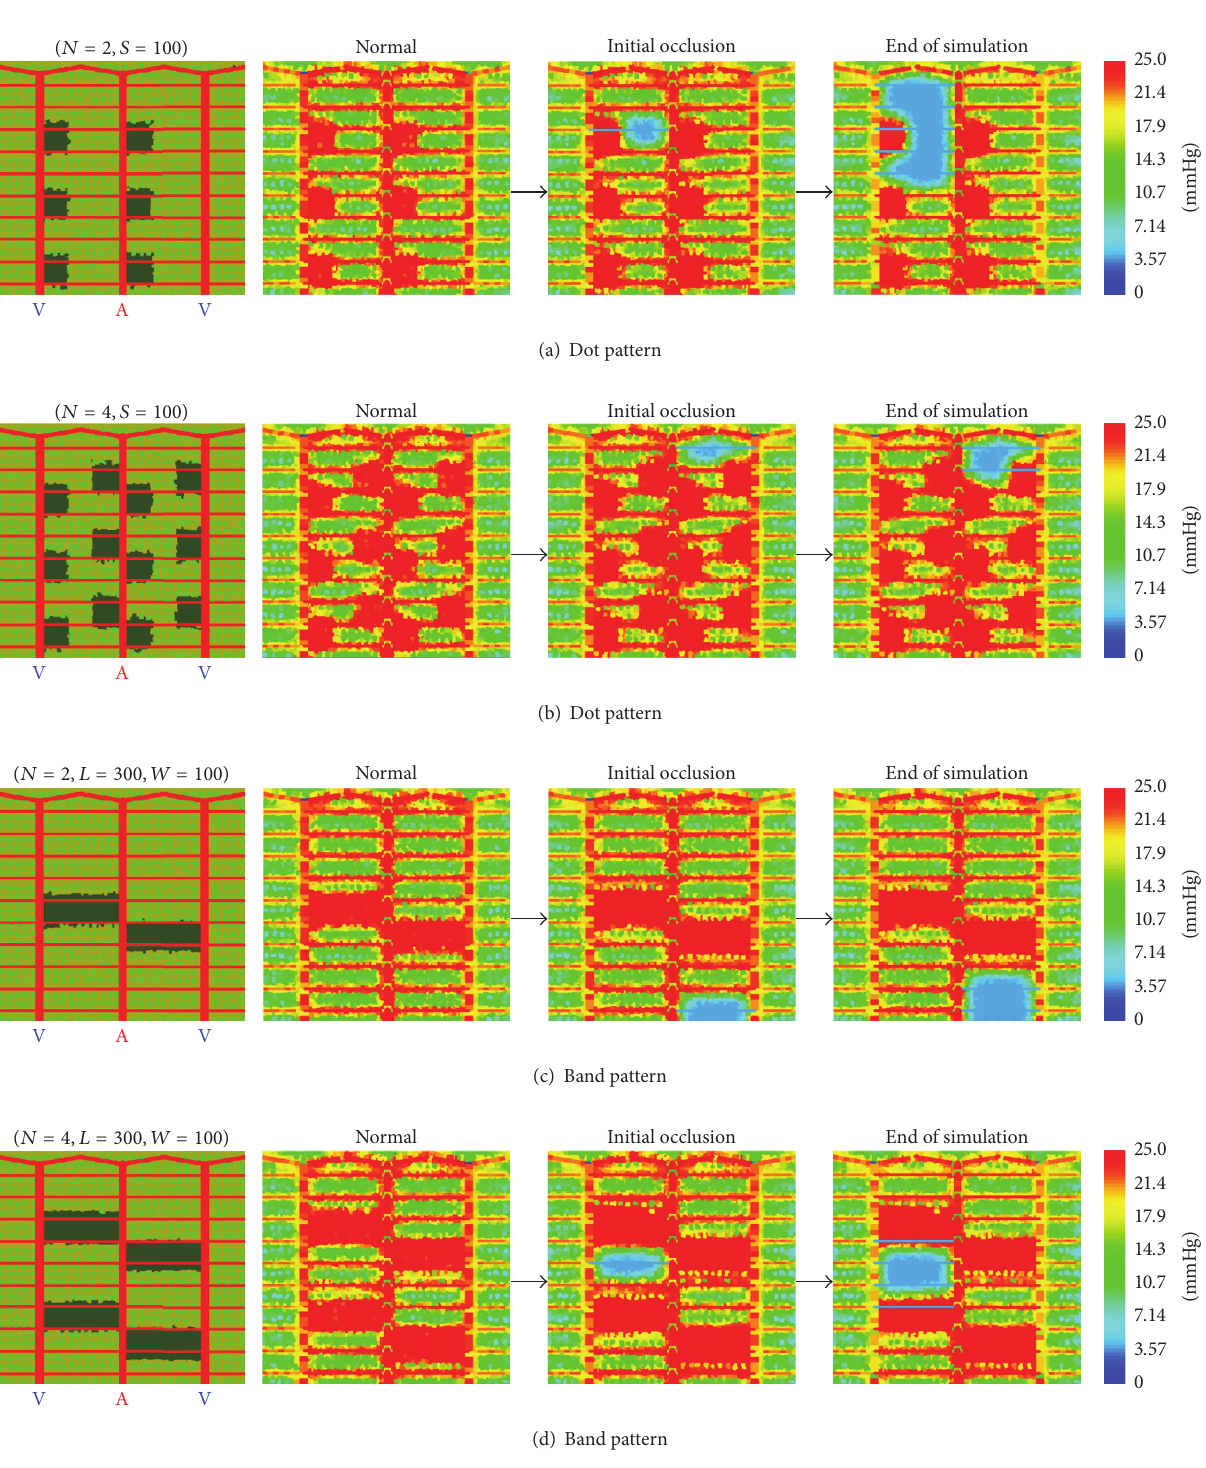
Figure 2: Dot and band burns patterns: effects of density. Effects of dot and band laser burn density on ischemia progression. Dot pattern burn (first subfigure rows (a) and (b)) with 𝑁 = 2 (a) and 𝑁 = 4 (b) and their effectiveness on prevention of ischemia progression (second to fourth subfigures in each row). Label 𝑁 = 2 indicates that the initial sum ablated area of these dot pattern burns is equivalent to that with two band pattern burns. Label 𝑆 = 100 means that the edge of the dot pattern burn is 100 microns. Band pattern burns (first subfigure rows (c) and (d)) with 𝑁 = 2 (c) and 𝑁 = 4 (d) and their effectiveness on prevention of ischemia progression (second to fourth subfigures in each row). Label 𝑁 = 2 means that number of laser burns is 2. Label “ 𝐿 = 300 , 𝑊 = 100 ” means that band pattern burn has length of 300 microns and width of 100 microns. Color bar for oxygen maps has unit mmHg. Warmer color in oxygen maps represents higher oxygen